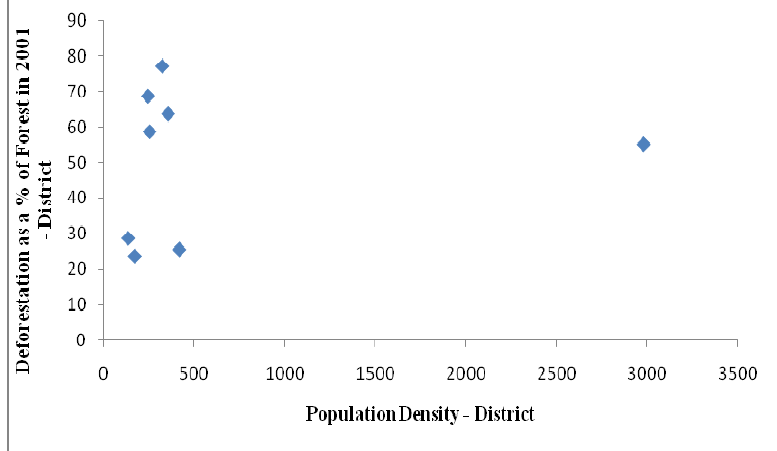
a percentage of the forest area existing in 2001, for districts.